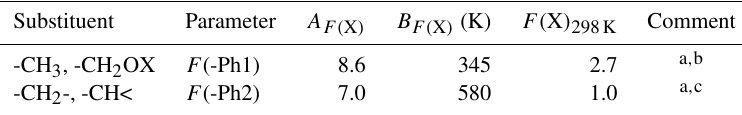
Table 1. Neighbouring group factors, F (X), for α -H-atom abstraction from substituents in aromatics, and their temperature dependences described by F( X ) = A F( X ) exp ( − B F( X ) /T ).